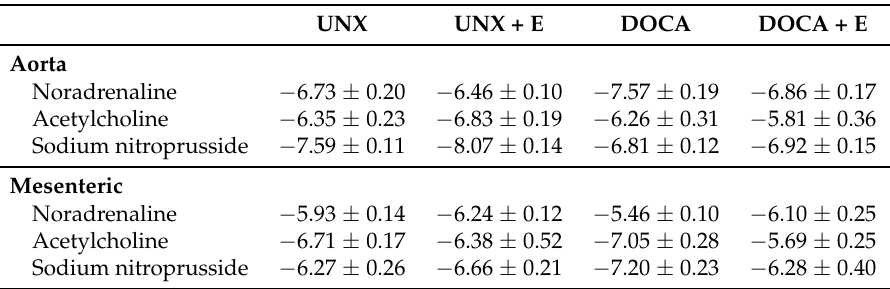
Table 2. Vascular EC 50 values.